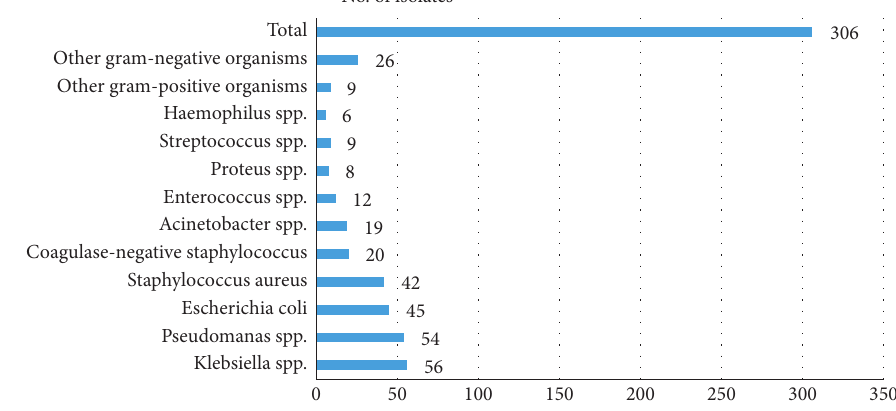
Figure 3: Distribution of bacterial isolates among cancer patients.